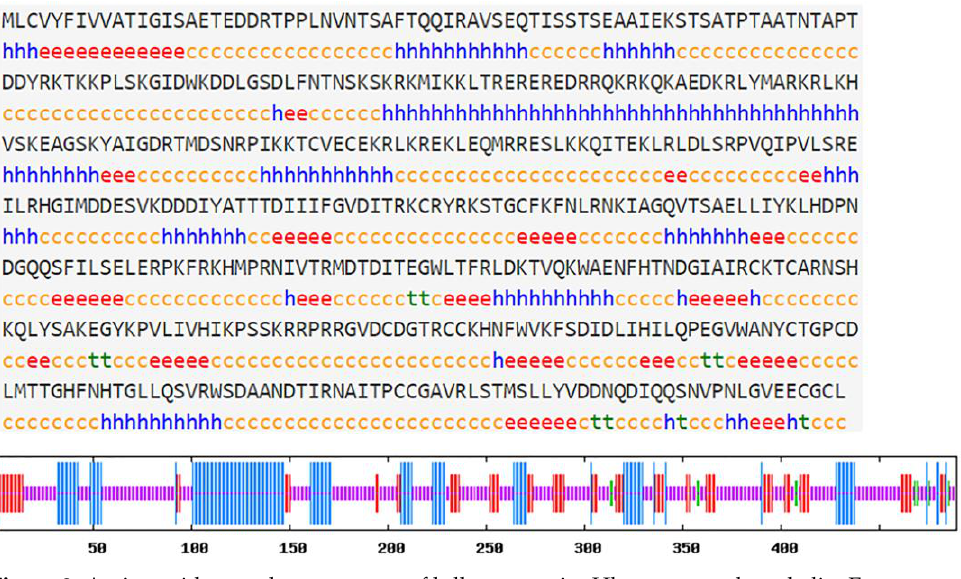
Figure 2. Amino acid secondary structure of hdh-myostatin. Hh expresses the α -helix. Ee expresses the extended strand. Tt expresses the β -turn. Cc expresses the random